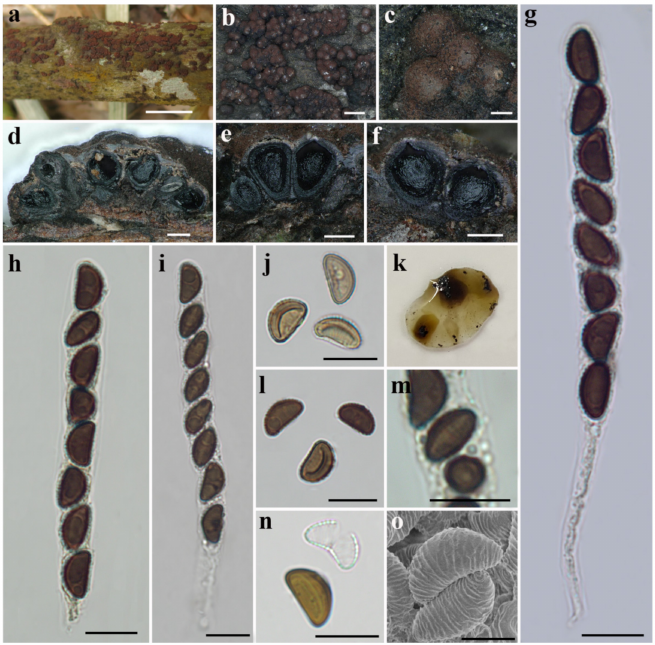
Figure 2. Hypoxylon chrysalidosporum (holotype FCATAS 2710). ( a ) Stromata on dead corticated branch. ( b , c ) Stromatal surface. ( d – f ) Stroma in vertical section showing the perithecia and tissue below the perithecial layer. ( g , h ) Ascus in Melzer’s reagent. ( i ) Ascus in water. ( j , l ) Ascospore in water. ( k ) KOH-extractable pigments. ( m ) Ascospores in Melzer’s reagent showing germ slit. ( n ) Ascospores in 10% KOH. ( o ) Ascospore under SEM. Scale bars: ( a ) = 1cm; ( b ) = 1 mm; ( c – f ) = 200 µ m; ( g – j , l – n ) = 10 µ m; ( o ) = 5 µ m. MycoBank: MB